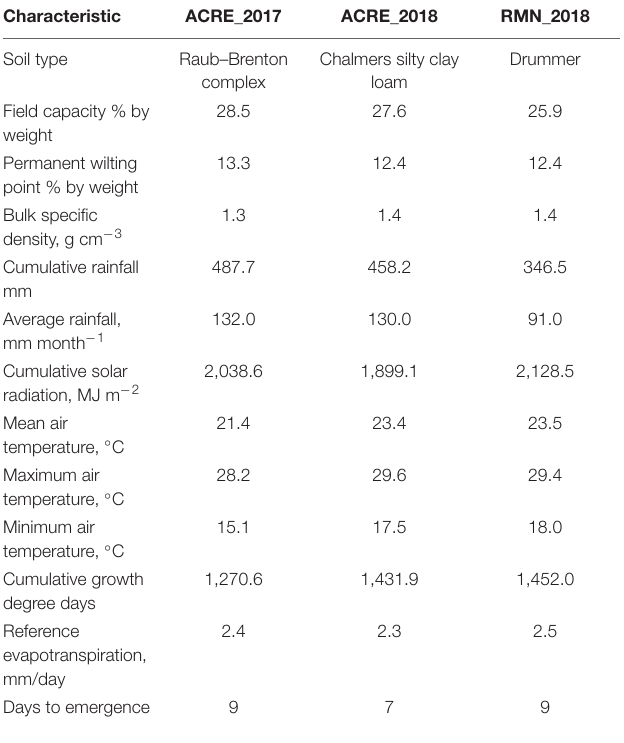
TABLE 1 | Main environmental characteristics for each